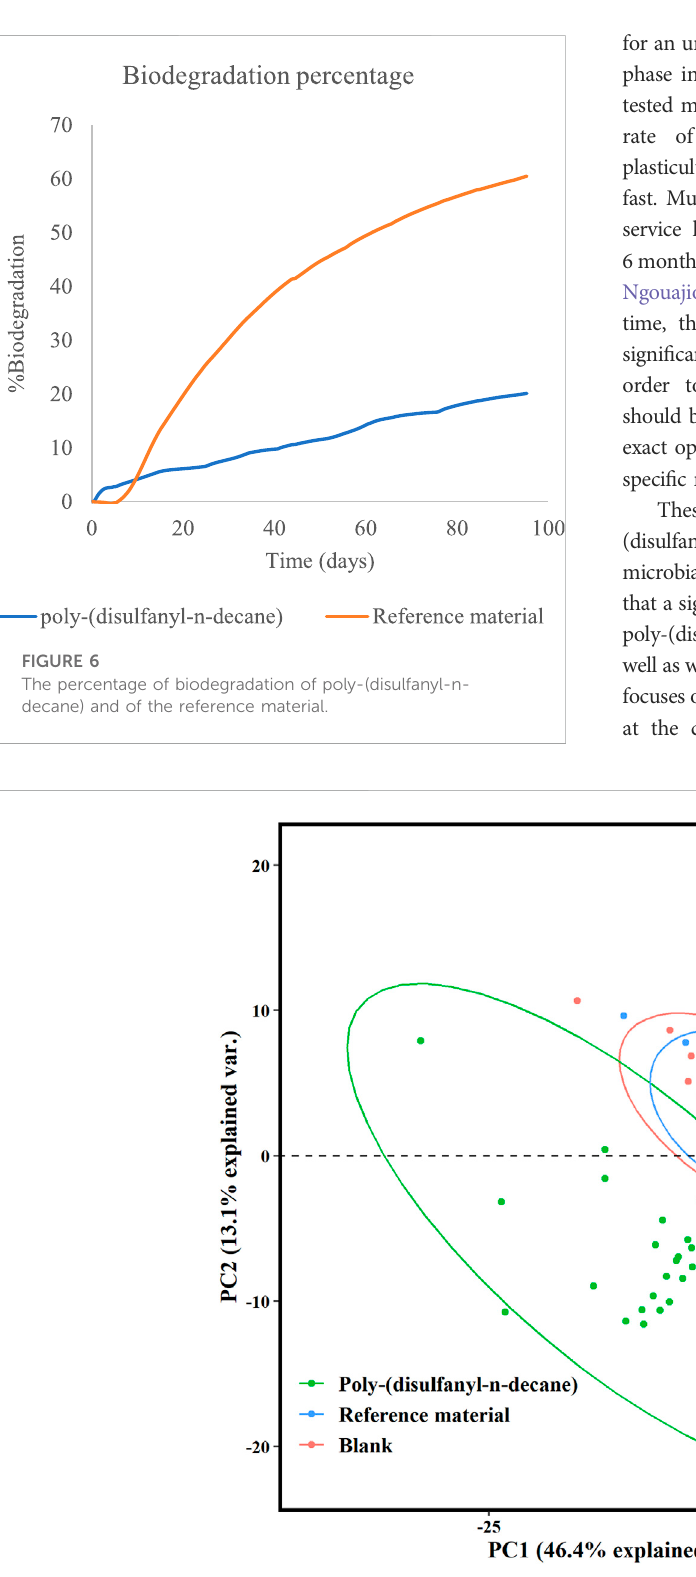
FIGURE 7 Score plot of the principal component analysis (PCA) for PTR-TOF-MS spectral data of the poly-(disulfanyl-n-decane) polymer, the reference material and the blank after 25 days. The fi rst principal component (PC1) and the second principal component (PC2) described 46.4 and 13.1% of the sample variability,